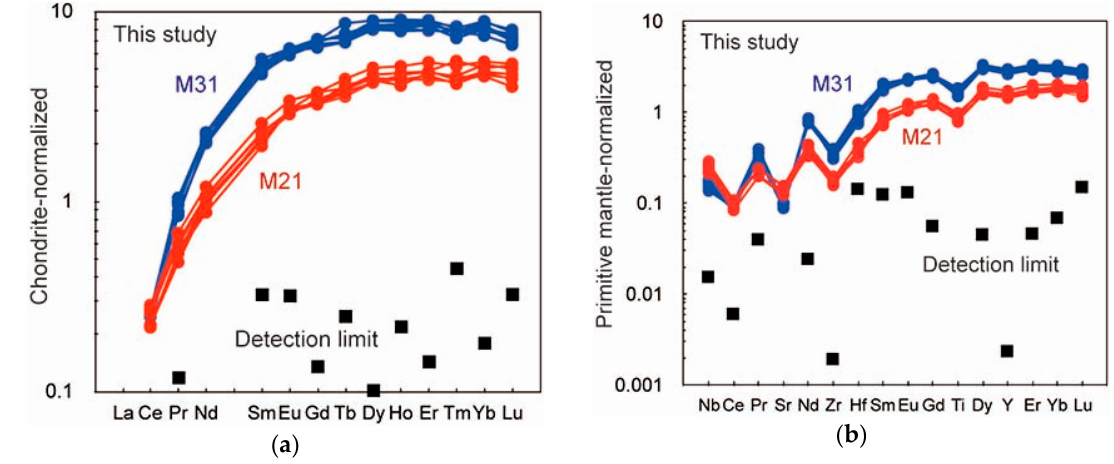
Figure 8. Relationship between the Al 2 O 3 contents of orthopyroxene porphyroclast core and the Cr# of spinel. The compositional ranges for mid-ocean ridge peridotites (MOR Peridotites) and Forearc peridotites are compiled by [25], and for the Andaman ophiolites are from [9].